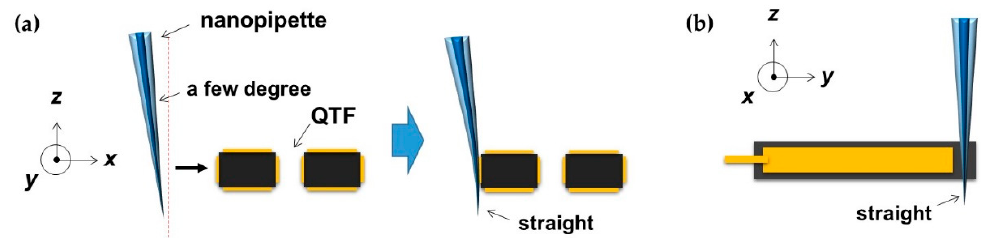
Figure 2. Attachment of the pulled nanopipette, which can be substituted with a nanorod to one prong of the quartz tuning fork (QTF) sensor: ( a ) The tip, inclined a few degrees, is accurately attached on the prong of the QTF perpendicular to the x -axis by pushing the tip further after contact with the prong of QTF for accurate force sensing from the apex of the tip; ( b ) installed tip straight to the y -axis.